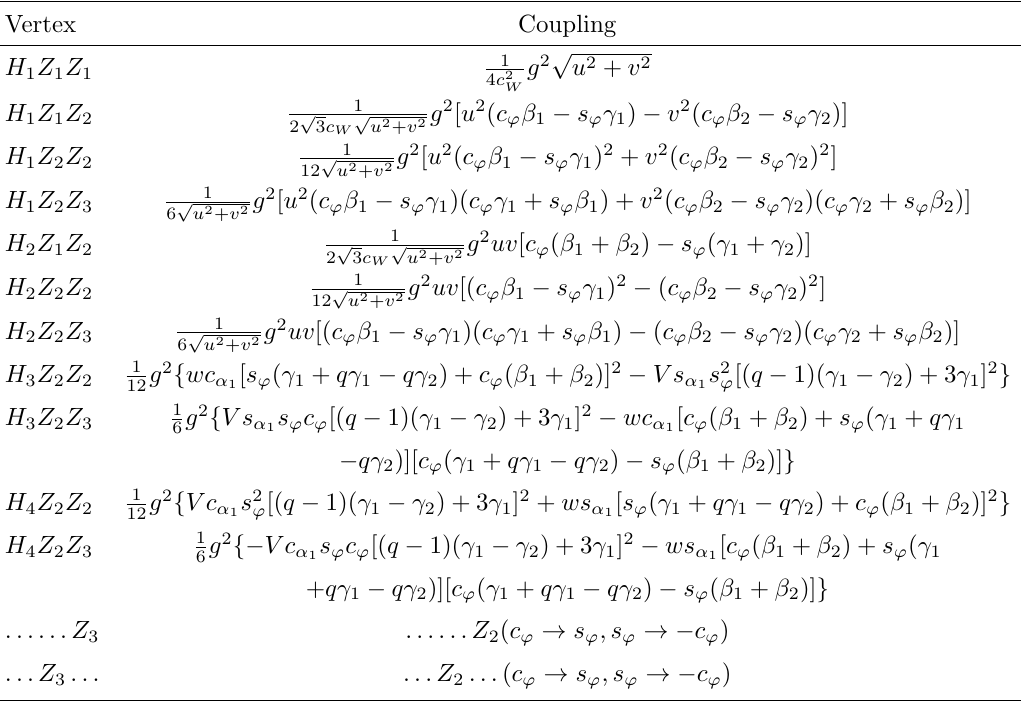
Table 11 . The interactions of a scalar with two neutral gauge bosons.